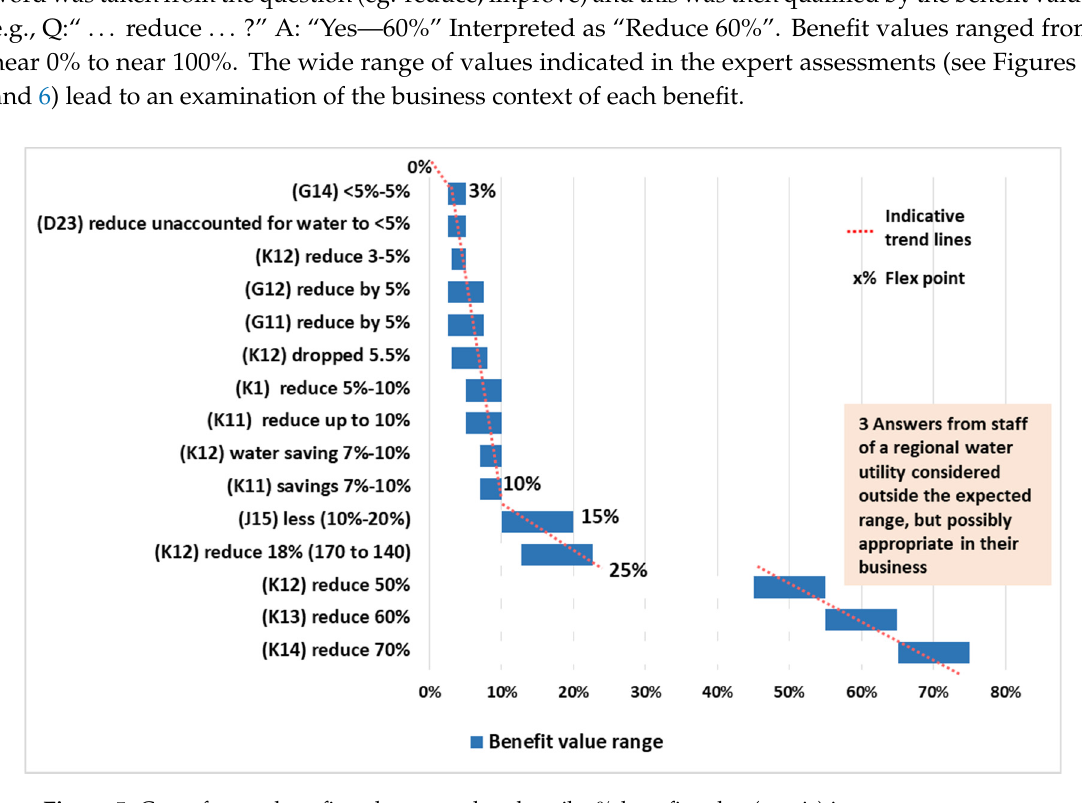
Figure 5. Cost of water benefits, phrase used to describe %-benefit value (y-axis) in expert assessments, shown as high-low ranges (rectangles), against the expected %-benefit value, i.e., savings (x-axis). These are arranged in ascending order of value (top to bottom), annotated with the relevant benefit question (brackets, y-axis), as well as indicative trend lines (red dotted line) with flex points added to aid description.